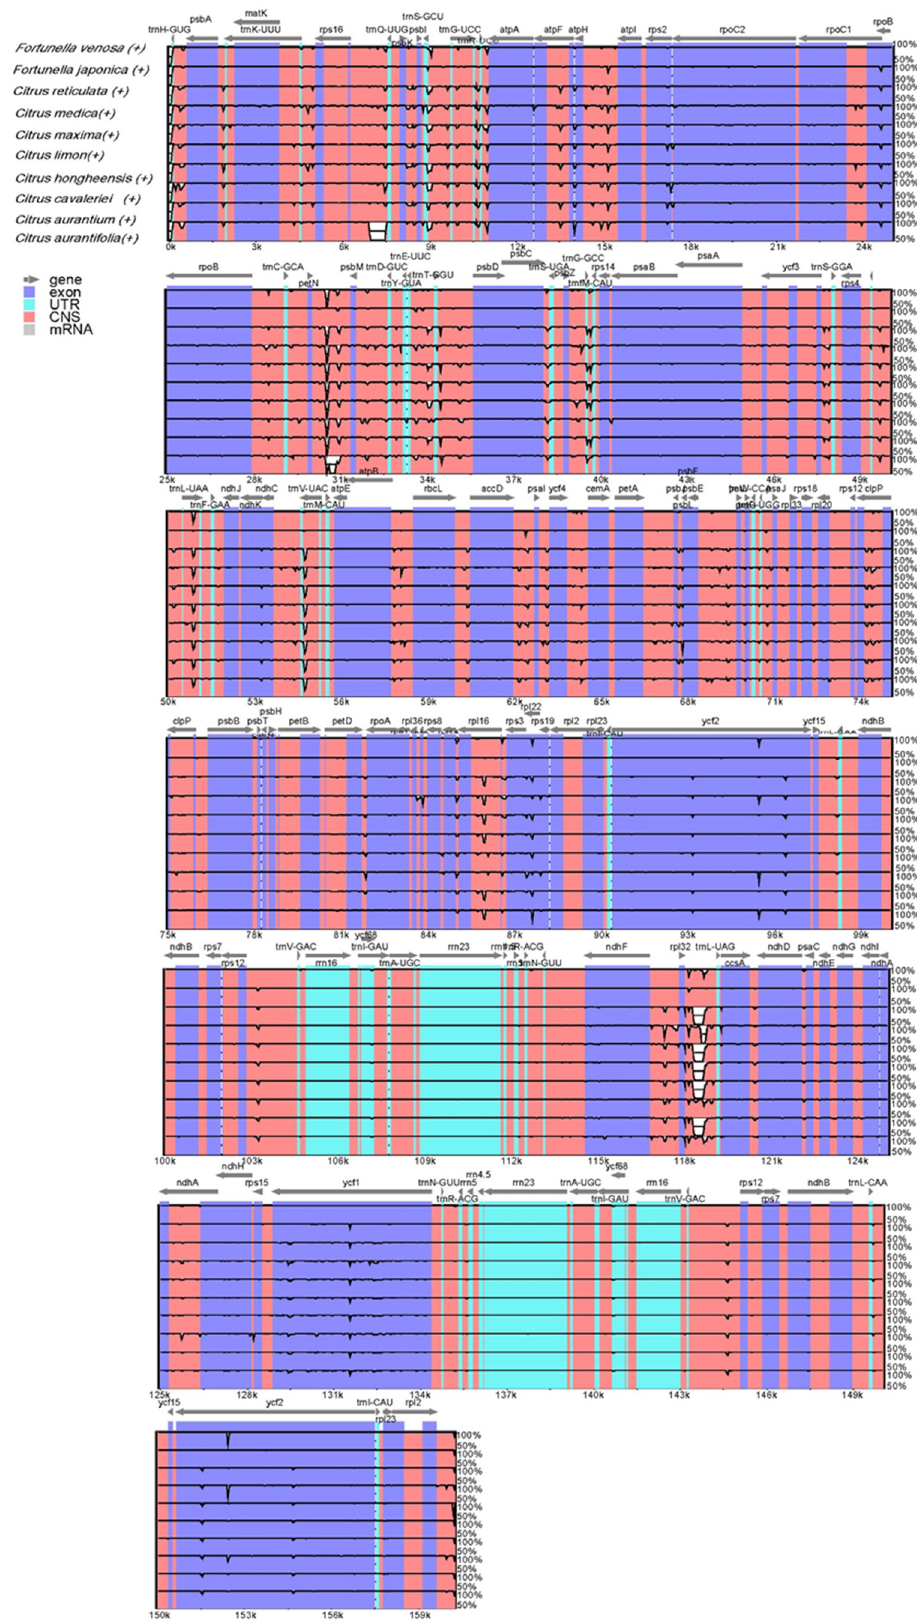
Figure 6. DNA sequence comparison of the ten species of Rutaceae. VISTA-based identity plot showing sequence identity among ten Rutaceae species using Fortunella venosa as a reference.